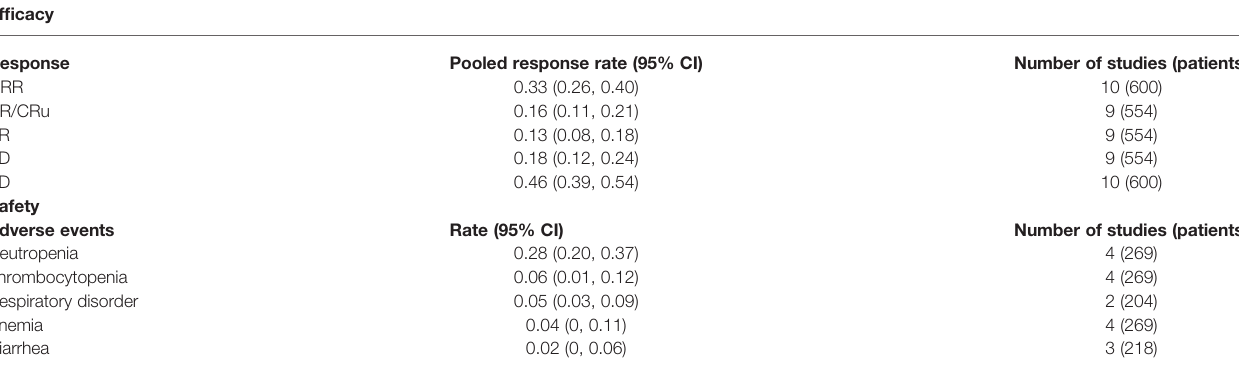
TABLE 3 | Pooled response rates and fi ve major adverse events ( ≥ Grade 3) in patients who received maintenance treatment consisting of lenalidomide monotherapy. Ef fi